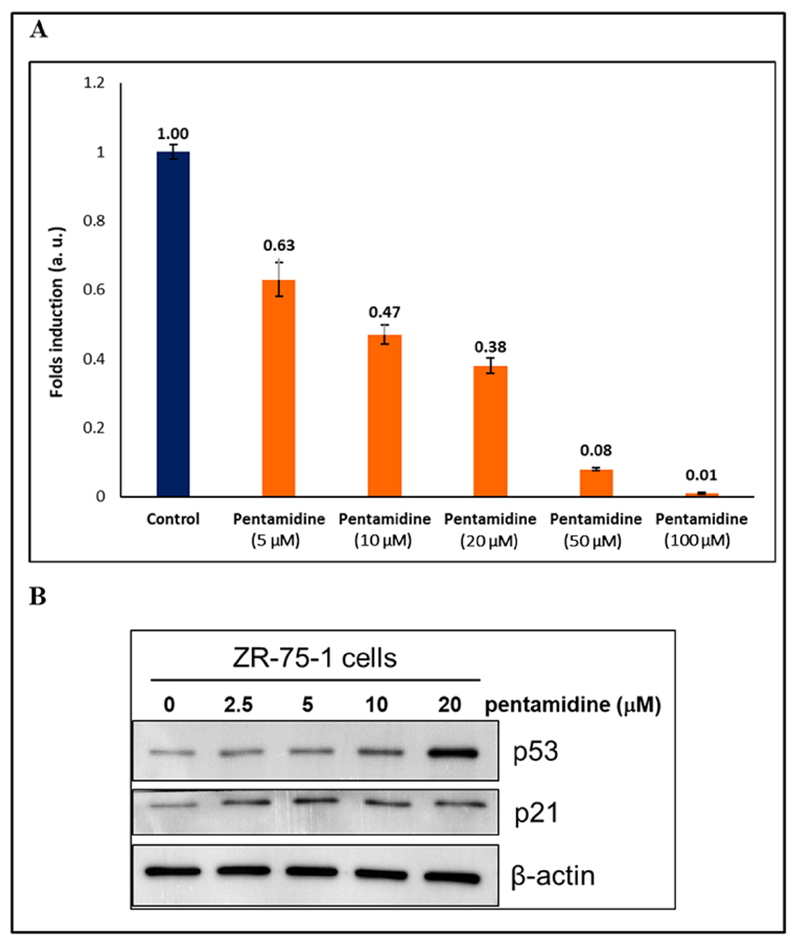
Figure 7. The effects of pentamidine on cell proliferation and p53 re-activation in ZR-75-1 breast cancer cells. ZR-75-1 cells were treated with indicated concentrations of pentamidine for 48 h. ( A ) Cell proliferation was determined by WST-1 assay. The bar diagram presented the relative folds of cell numbers in treated group (orange bars) comparing to that of untreated control group (blue bar). The values on the top of the bars were mean of three replicates. ( B ) Cell lysate was extracted from each treatment, and separated by SDS-PAGE, followed by Western blotting of p53, p21, and β -actin proteins. Beta-actin was a housekeeping protein used as the internal control of each treatment.